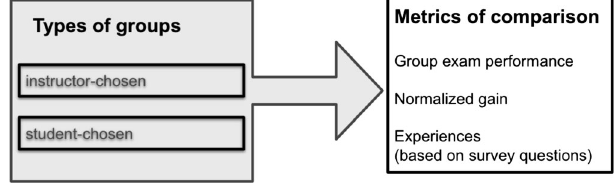
FIG. 2. Experimental method.